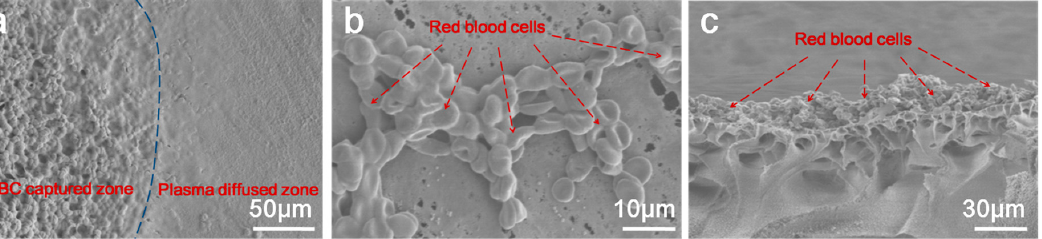
Figure 2. SEM images of the ( a , b ) surface and ( c ) cross-section of CA@PEG-2000 membranes after blood cell separation. The dotted blue line represents the dividing line between blood cells and plasma.